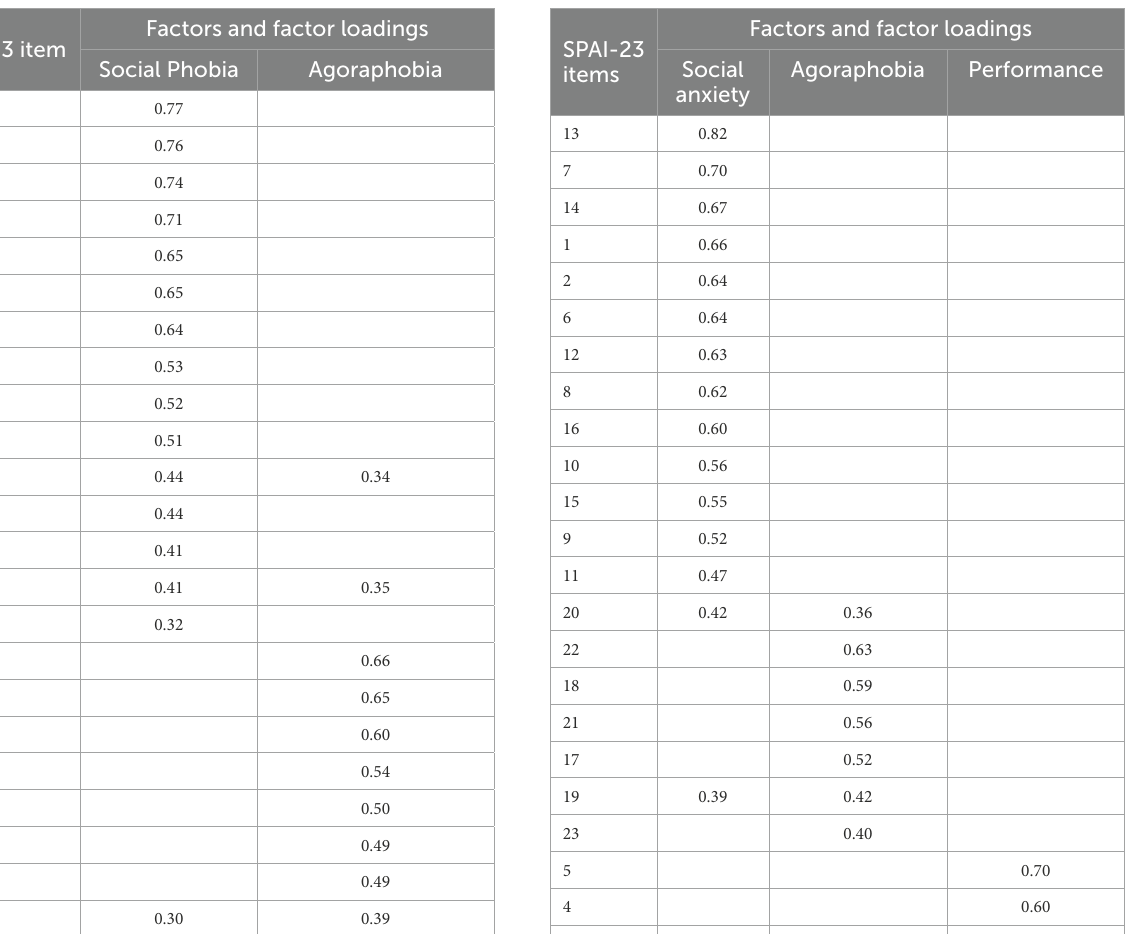
TABLE 2 Results of a two factor solution from a forced EFA using PAF and oblique rotation.